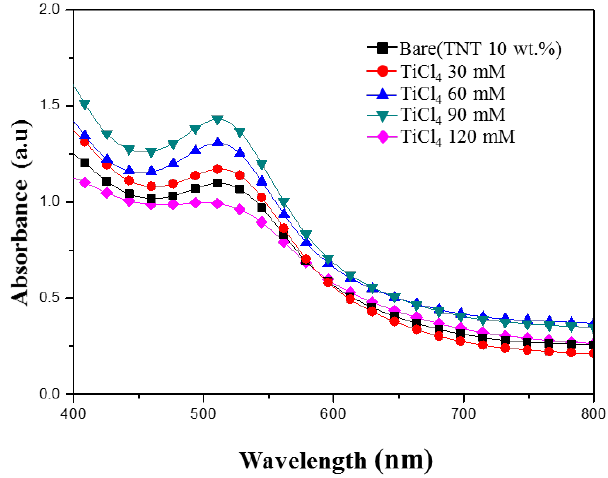
post treated TiO 4